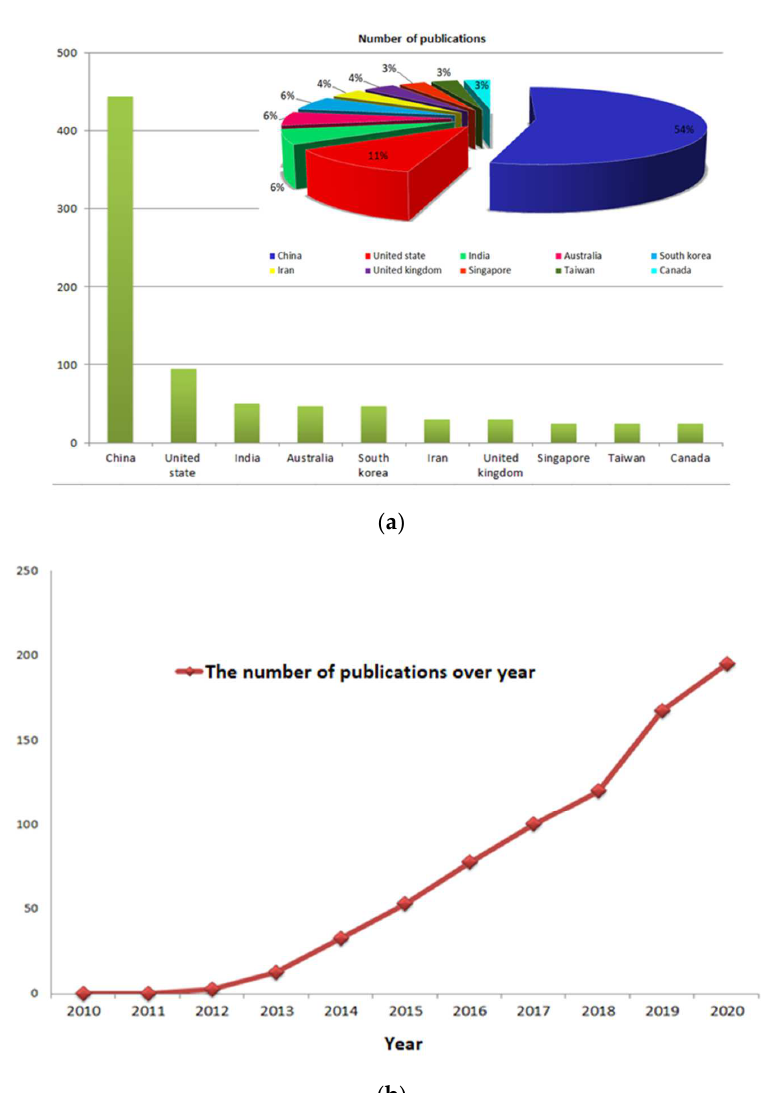
Figure 3. The number of publications that are related to this research topic. Data were obtained from the Scopus database from the years 2011–2020 [104]. ( a ) Percentage of publication according to the country of the authors;( b ) Publications over year.